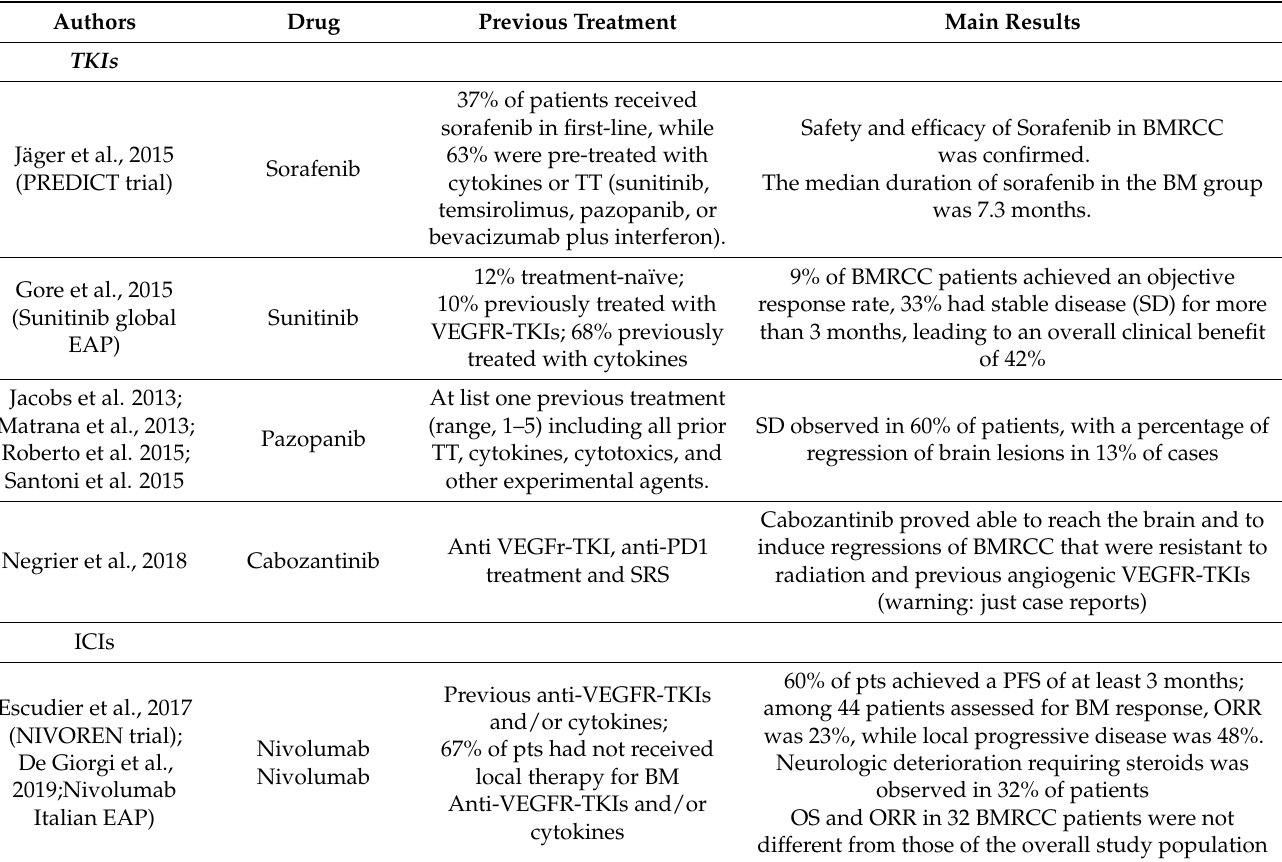
Table 2. Effect of systemic therapy (anti-VEGFR-TKIs and ICIs) on